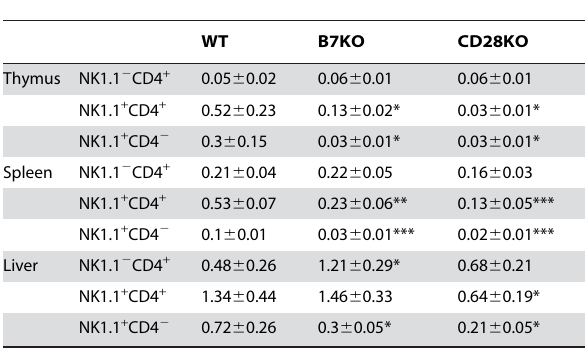
Table 1. Different iV a 14 NKT subsets in total lymphocytes of thymus, spleen and liver in WT, B7-1/2 and CD28 deficient mice.